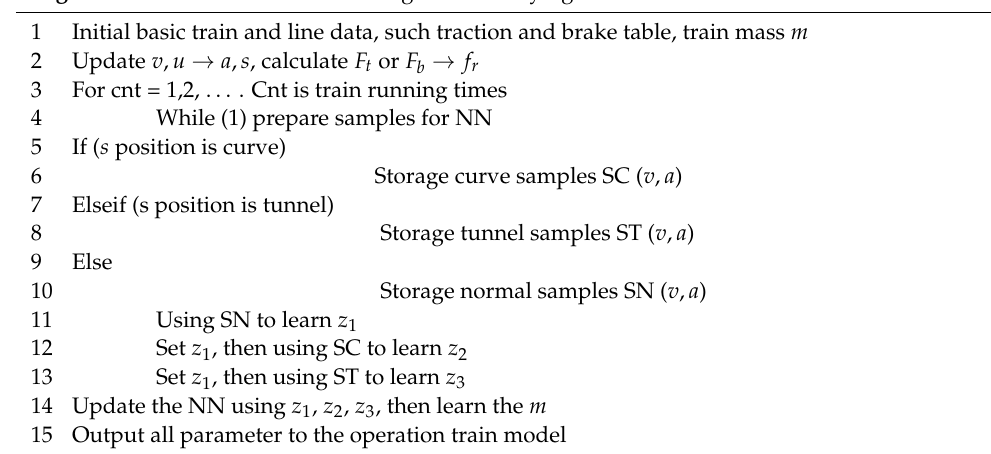
Algorithm 1: Neural network learning of time-varying